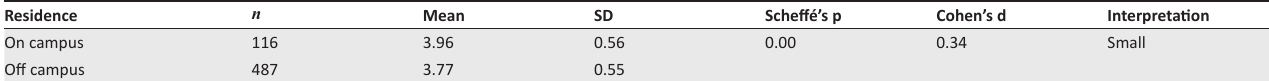
TABLE 8: The practical significance of the impact of residence on organisational identification.